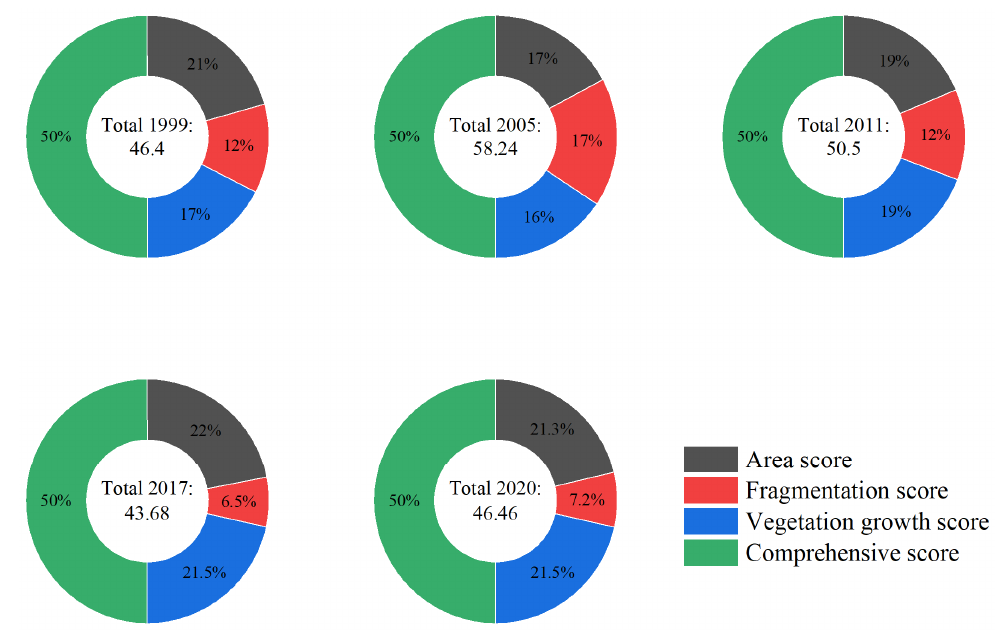
Figure 8. Bird habitat score map of reed wetlands, 1999–2020. Table 5. Bird habitat rating table in waters from 1999 to 2020.